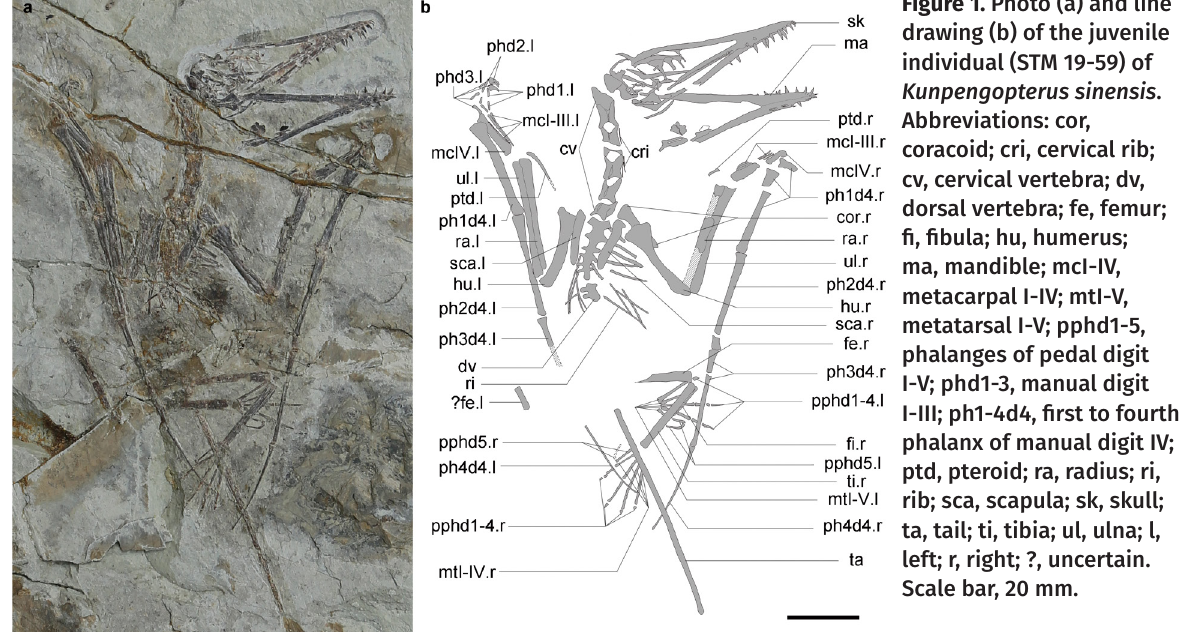
Figure 1. Photo (a) and line drawing (b) of the juvenile individual (STM 19-59) of